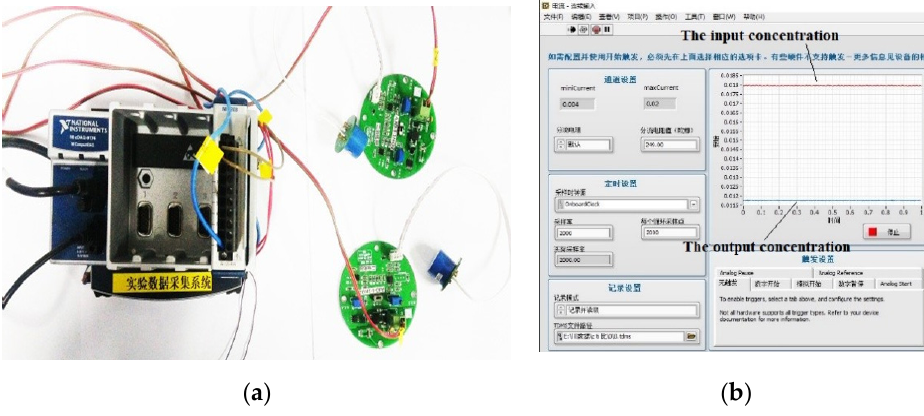
Figure 3. Testing probe ( a ) and data collection system ( b ).